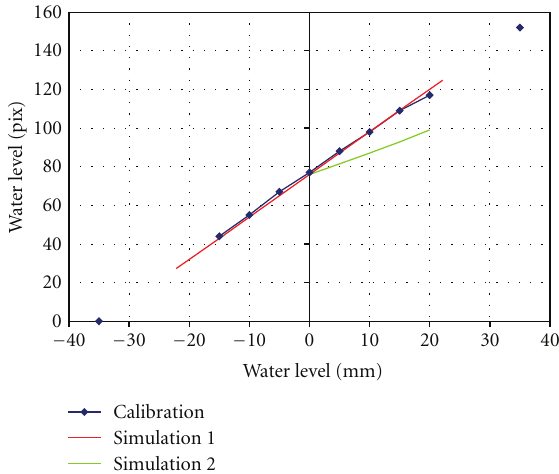
Figure 4: Vertical resolution of the optical observation: comparison between experimental calibration and